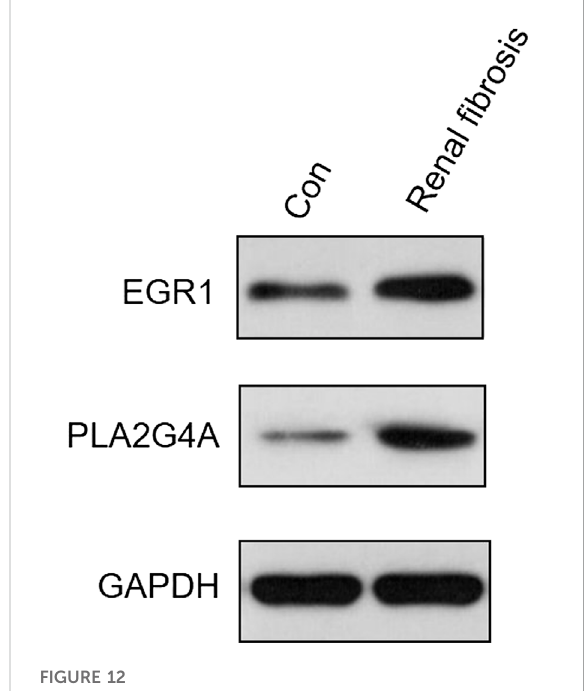
FIGURE 12 EGR1 and PLA2G4A protein expressions were analyzed by Western blot in renal fi brosis and adjacent normal